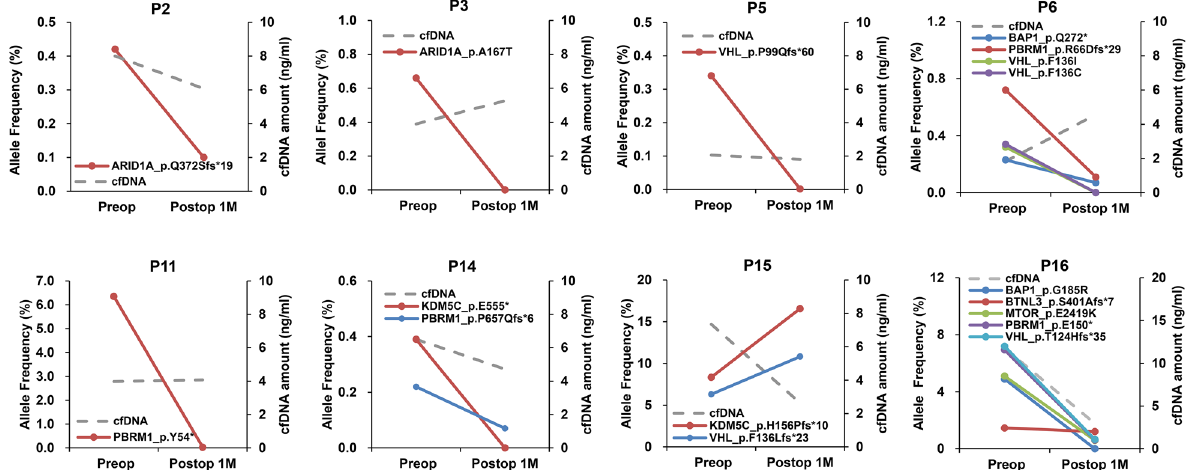
Figure 3. Post-operative circulating tumor DNA (ctDNA) dynamics in patients with renal cell carcinoma (RCC) who underwent radical nephrectomy. Patient blood samples were collected before and 1 month after radical nephrectomy; the ctDNA diversities and levels as assessed by targeted deep sequencing are indicated on the y-axis.